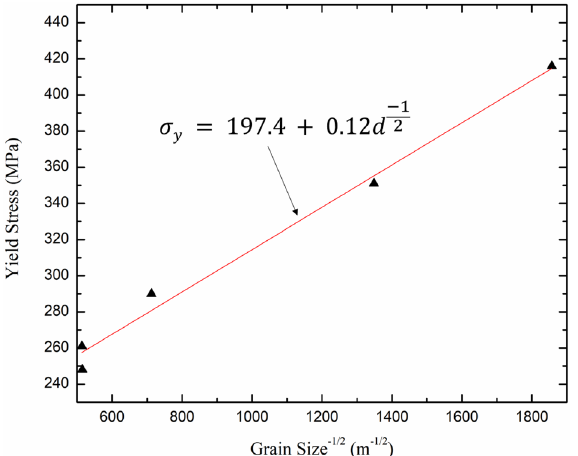
Figure 6. Yield stress-grain size relationship of the electroplated Cu